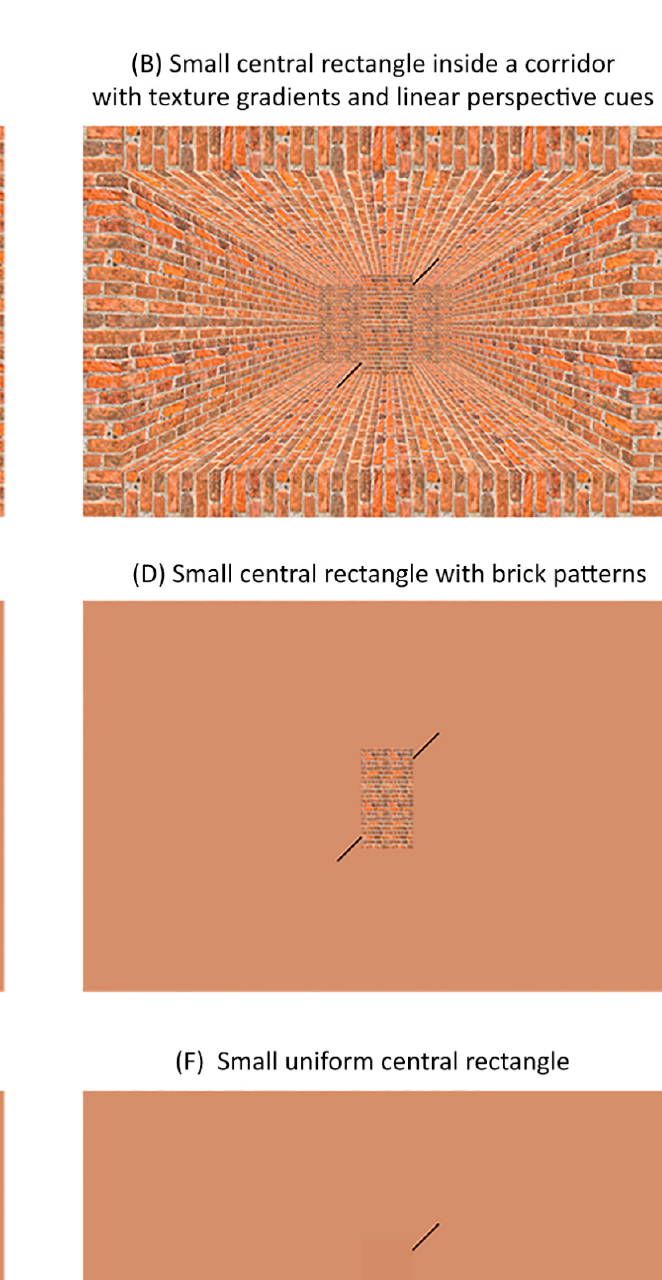
Figure 1. Poggendorff figures used to test for the effect of texture cues on the magnitude of the Poggendorff illusion in experiment 1. The Poggendorff stimuli consisted of ( A ) a uniform central rectangle, ( B ) a central rectangle with large bricks, ( C ) a central rectangle with small bricks and ( D ) no central rectangle. Similar central rectangles in ( A – C ) were used by Talasli and Inan [3] .